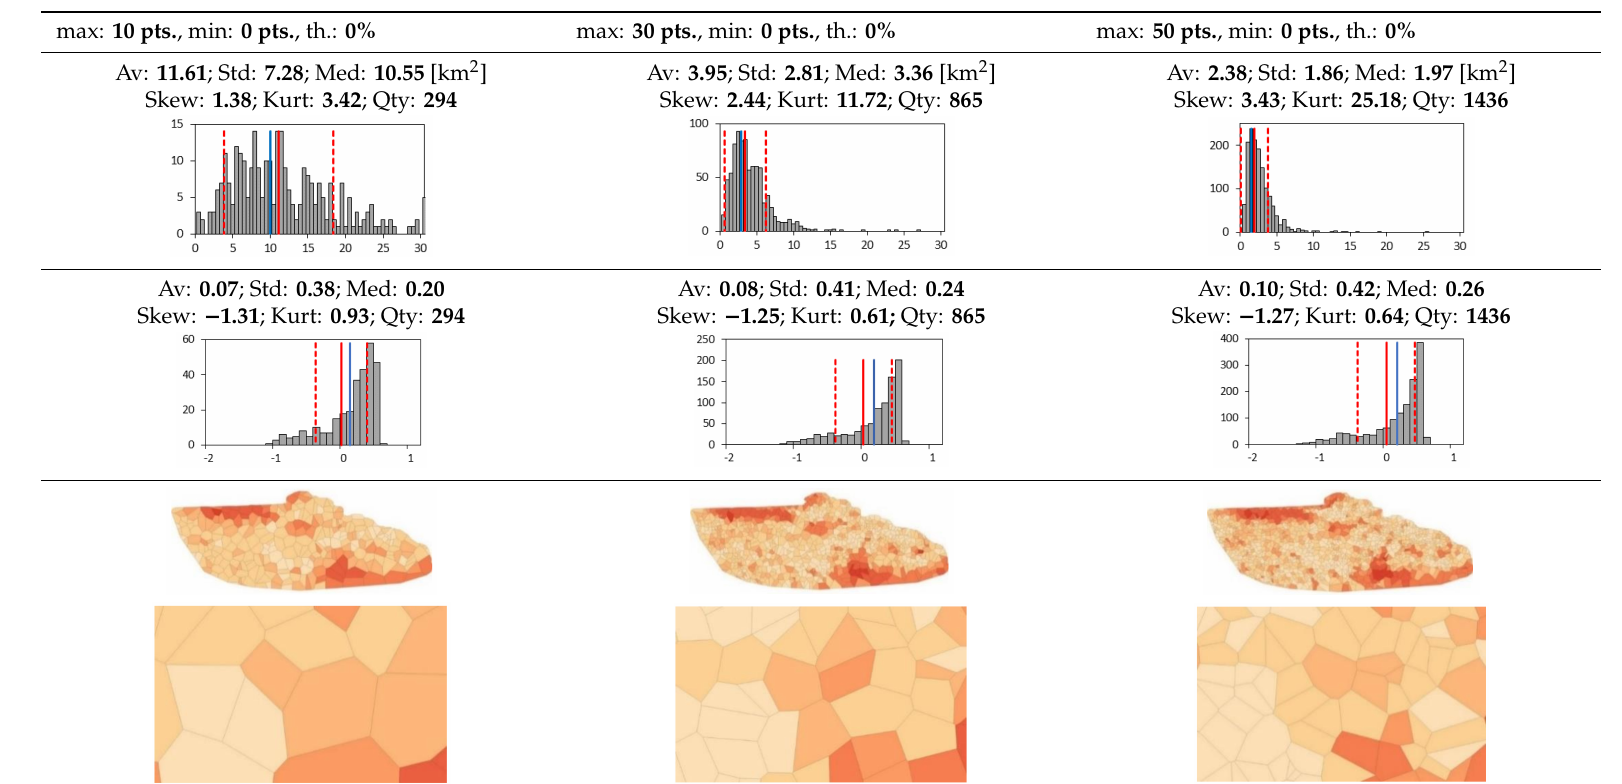
Table 6. Results for the points generated in 8 × 8 km 2